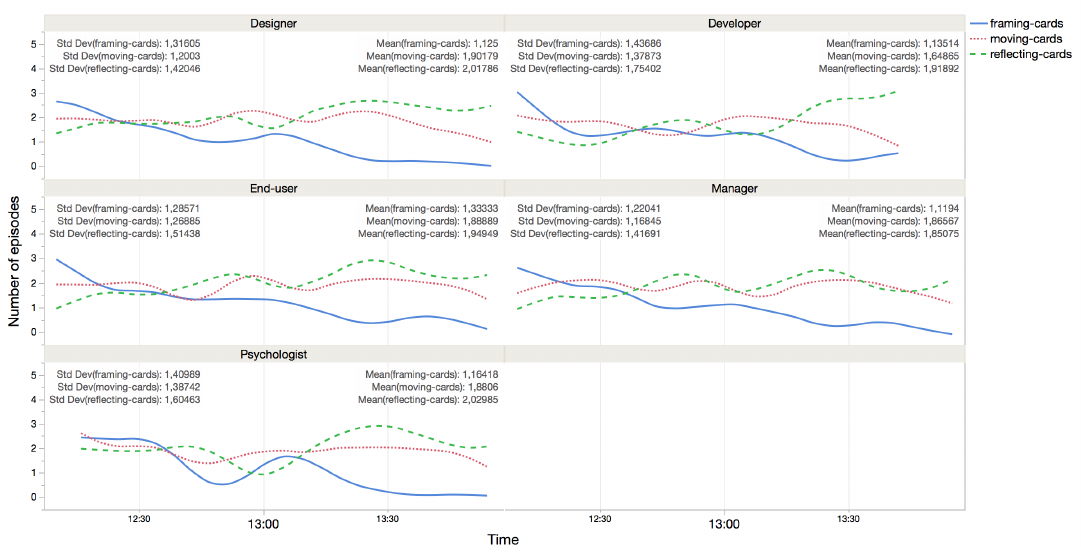
Figure 8. Episodic activity across disciplines, with cards.